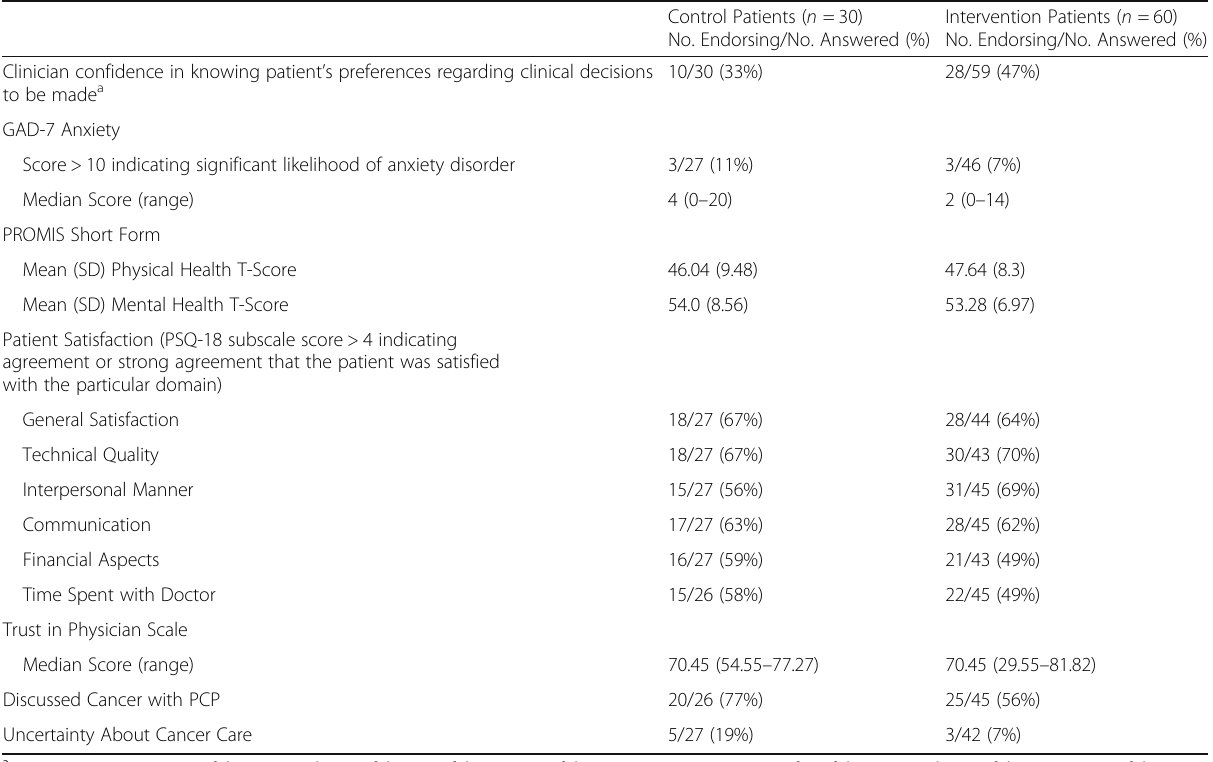
Table 2 Comparison of Psychosocial and Satisfaction Outcomes in Control and Intervention Patients